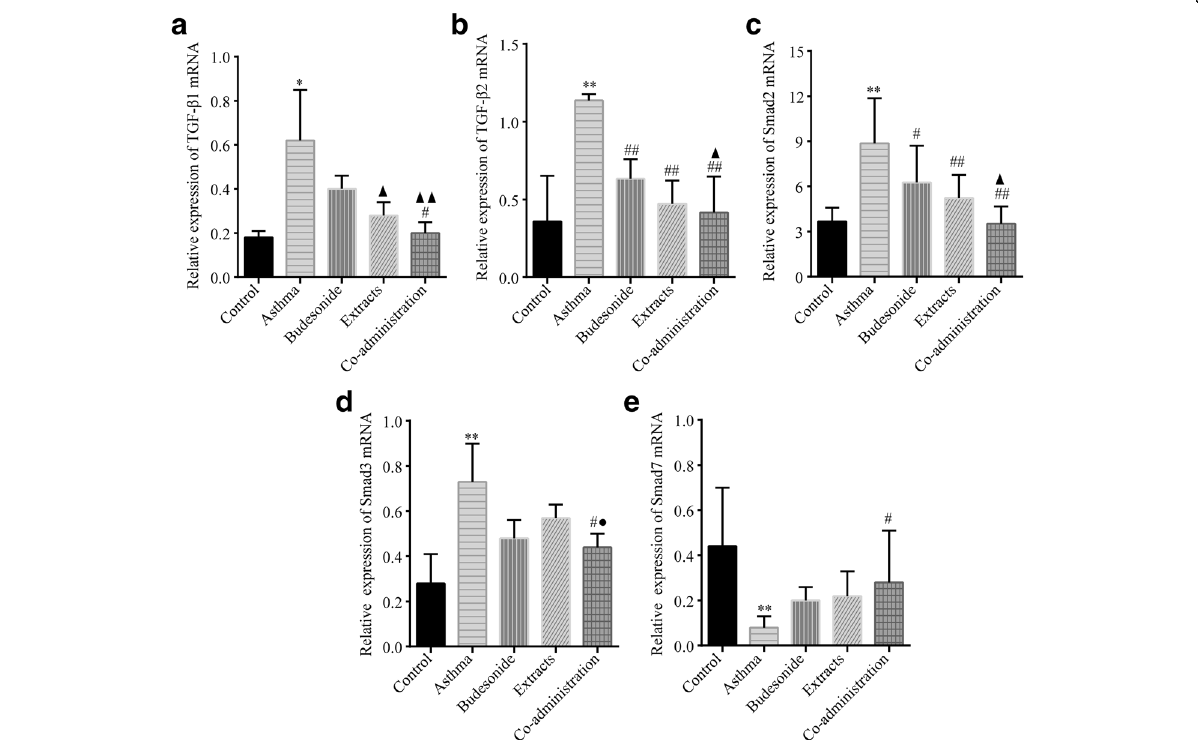
Fig. 5 Effects of budesonide and the herbal extracts on mRNA expression of TGF- β /Smads. The mRNA expressions of TGF- β 1 ( a ), TGF- β 2 ( b ), Smad2 ( c ), Smad3 ( d ) and Smad7 ( e ) in lung tissue were determined by qPCR with β -actin as an internal control. In the asthmatic rats, the mRNA expressions of TGF- β 1, TGF- β 2, Smad2 and Smad3 were significantly higher, while that of Smad7 was significantly lower than those in the normal group. Mean ± SD, n = 7. * P < 0.05 and ** P < 0.01 compared to normal control group; # P < 0.05 and ## P < 0.01 compared to asthma model group; ▲ P < 0.05 and ▲▲ P < 0.01 compared to budesonide group; ● P < 0.05 compared to extracts